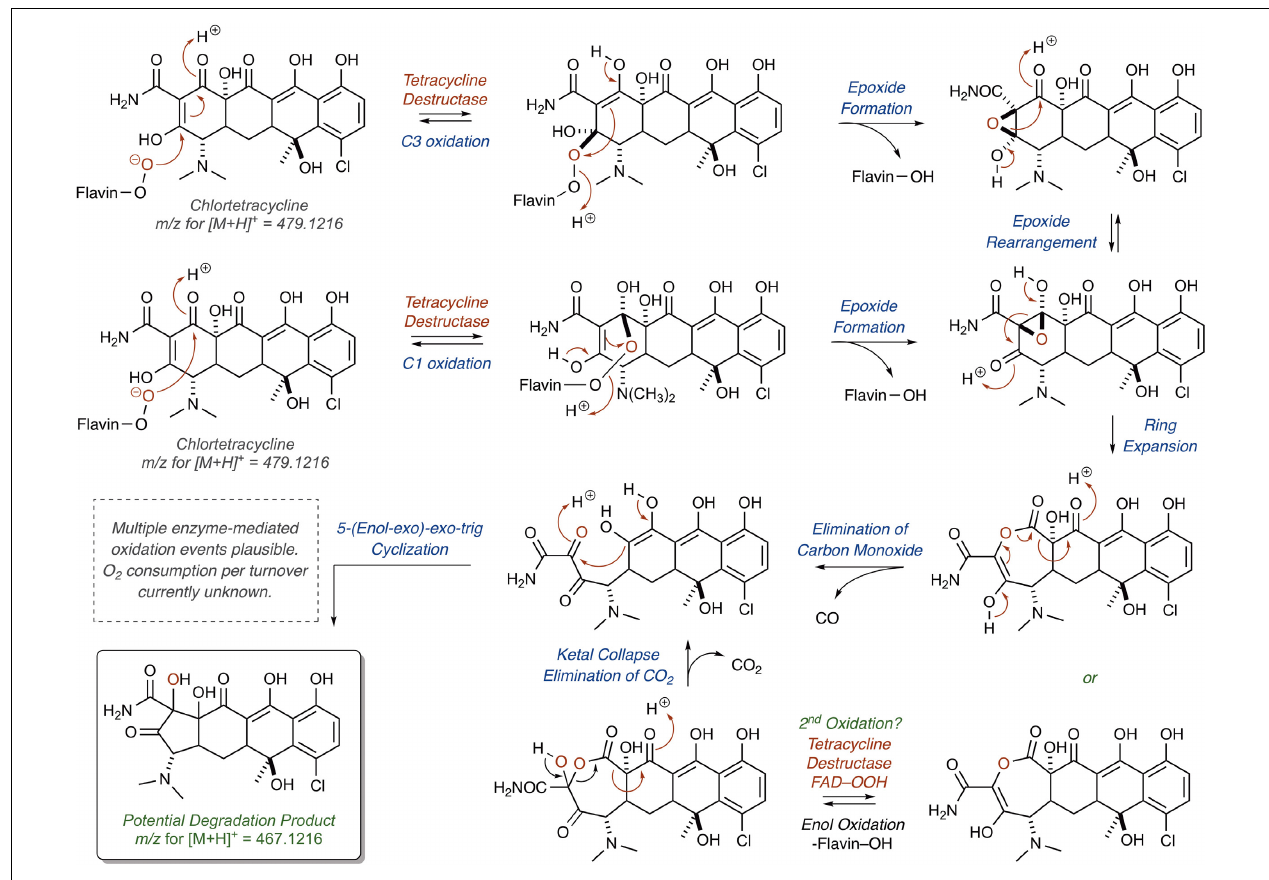
FIGURE 9 | Cascade reactions leading to tetracycline degradation products from enzymatic C1- or C3-oxidation of mode II A , D -bound